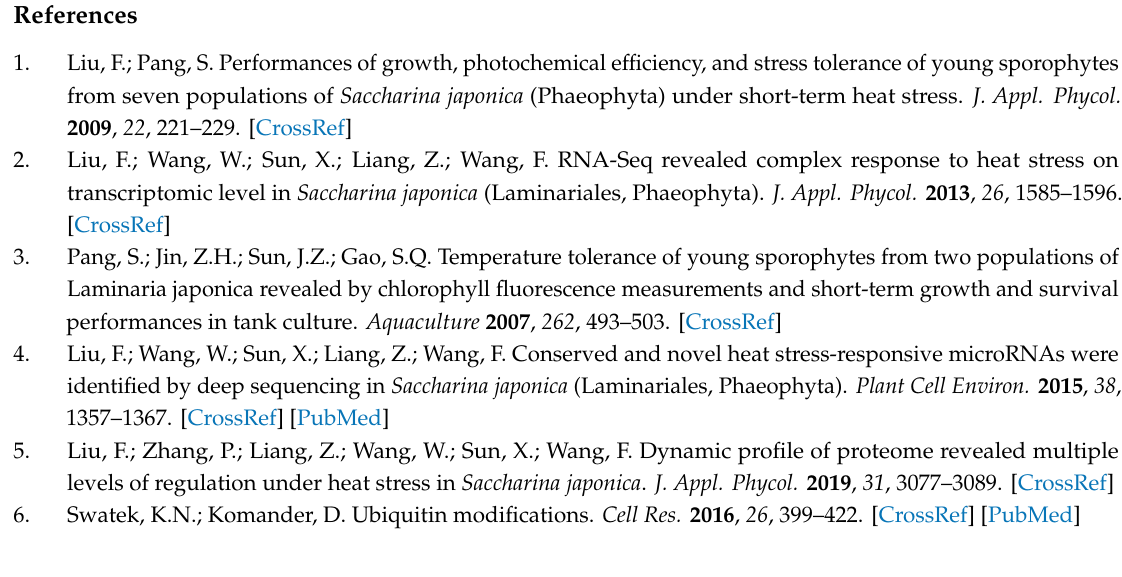
Table S1. Di ff erentially expressed statistics; Table S2. GO_enrichment data; Table